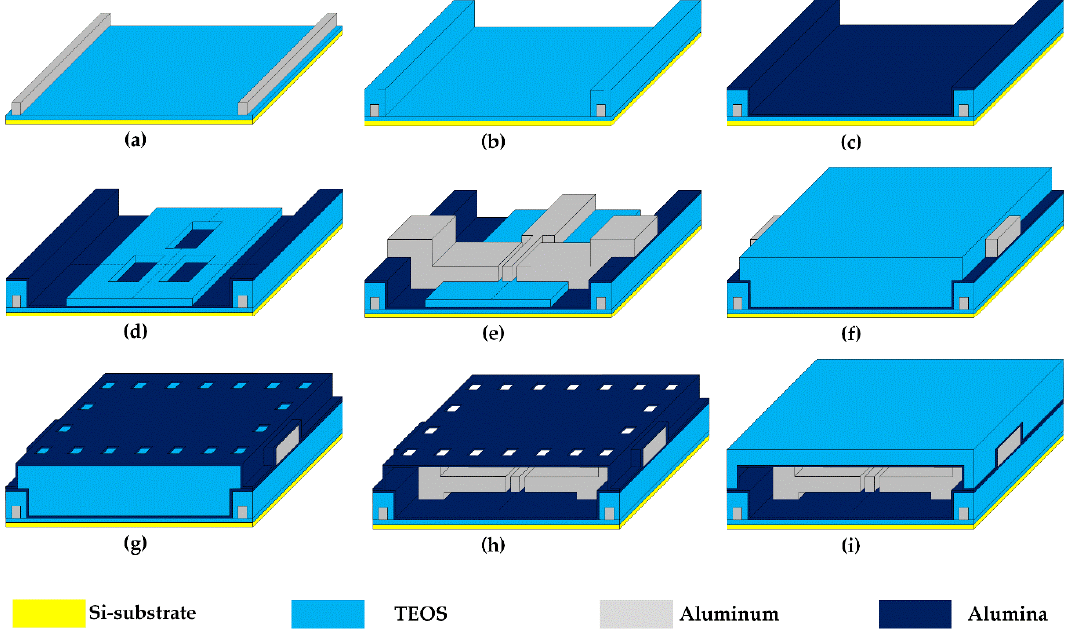
Figure 2. Key process steps of the encapsulated nanoelectromechanical (NEM) memory switches. ( a ) Al deposition and patterning for the formation of metal interconnection lines. ( b ) Tetraethyl orthosilicate (TEOS) deposition and patterning for inter-metal-dielectric (IMD) formation. ( c ) Al 2 O 3 bottom passivation layer deposition. ( d ) Lower TEOS sacrificial layer deposition and patterning. ( e ) Al deposition and patterning for the formation of a NEM memory switch. ( f ) Upper TEOS sacrificial layer deposition and pattern. ( g ) Al 2 O 3 top passivation layer deposition and etch hole formation. ( h ) Removal of the lower/upper sacrificial layers through etch holes by using vapor hydrogen fluoride (HF) etching. ( i ) TEOS deposition for cavity sealing.